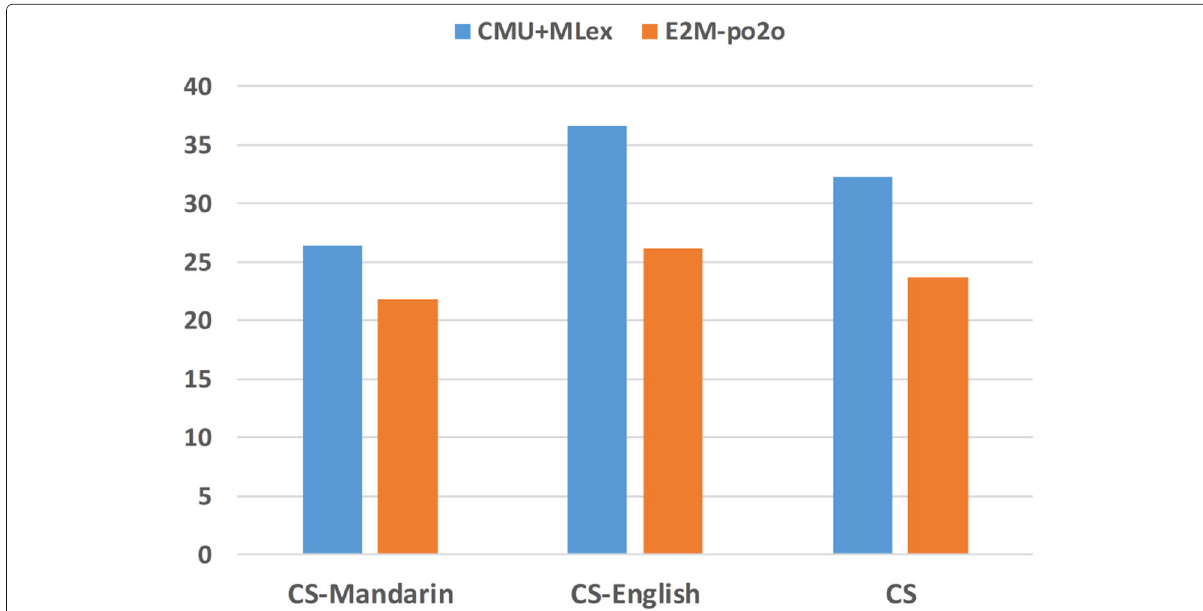
Fig. 4 TER% between Mandarin and English part of code-switching test set with different phone mapping